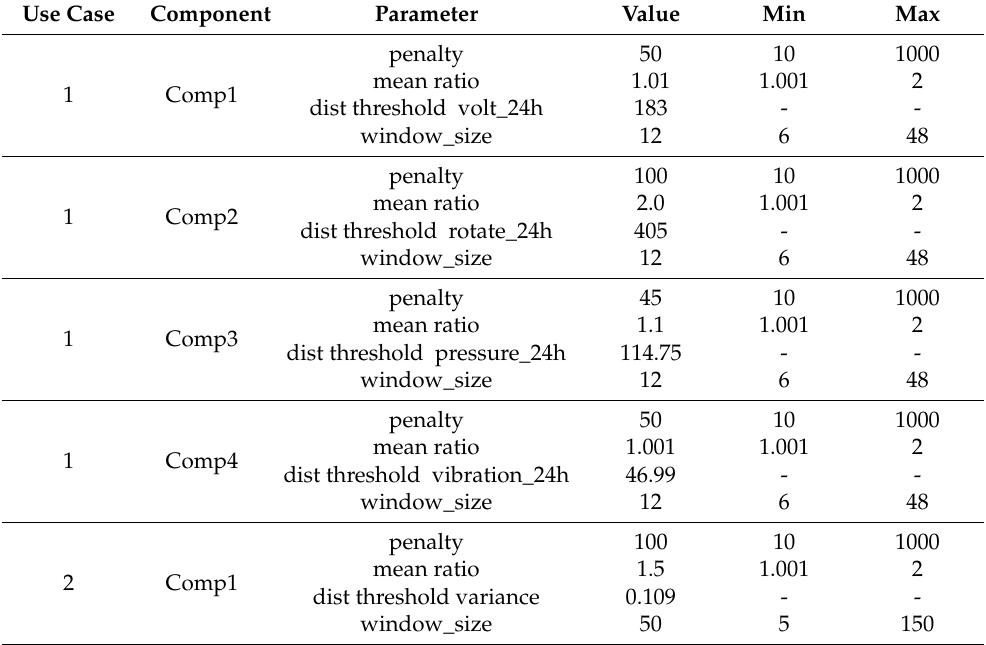
Table 3. Trained